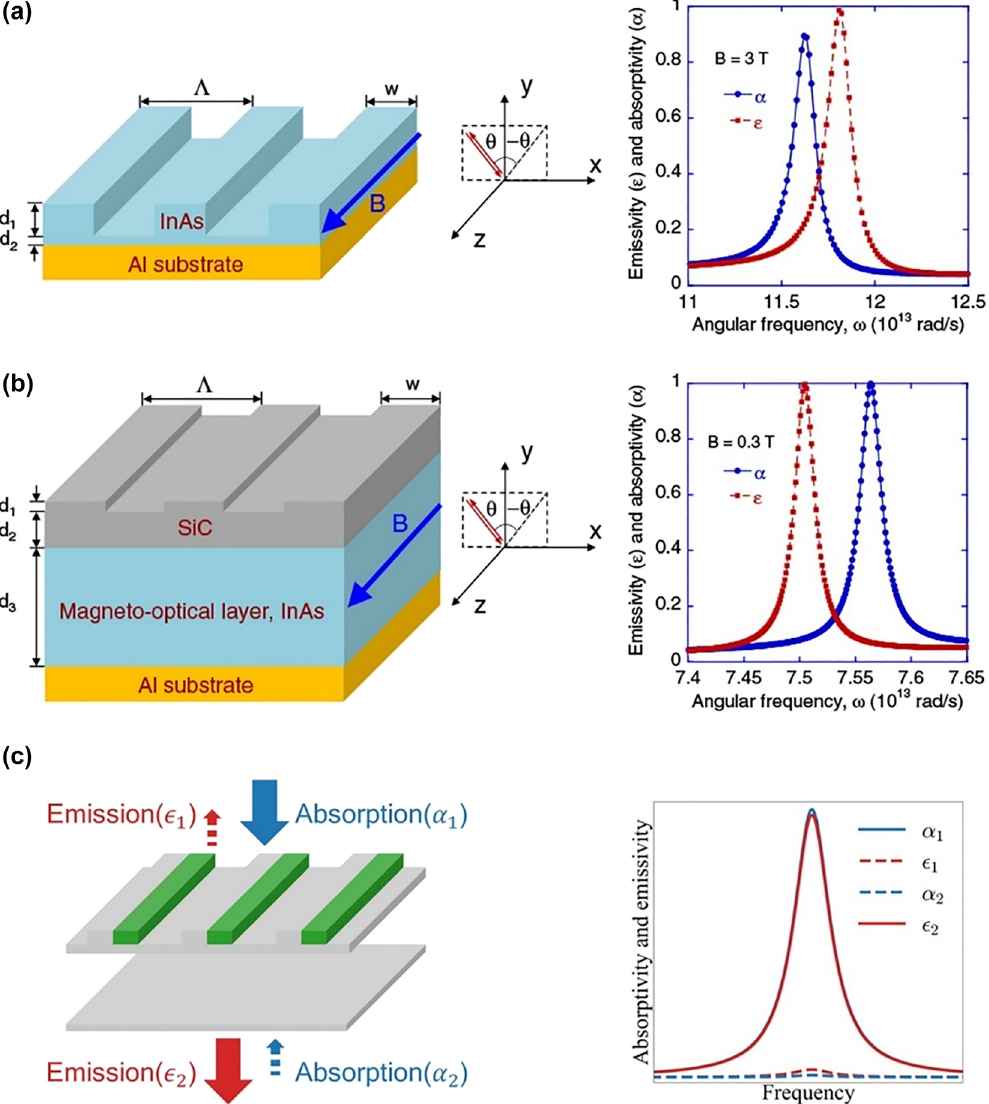
Figure 6: Violation of Kirchhoff ’ s law of thermal radiation in all-dielectric MO subwavelength gratings. (a) Structure, absorption, and emission spectra of InAs gratings on an Al substrate under 3 T applied magnetic fi eld. The emission and absorptionspectrapresentdifferentpeakpositionsundertheappliedmagnetic fi eld.(b)Structure,absorption,andemissionspectrumof SiC grating on InAs fi lm on an Al substrate under 0.3 T applied magnetic fi eld. The emission and absorption peaks separate under the applied magnetic fi eld. (c) All-dielectric MO grating for violation of the Kirchhoff ’ s law of thermal radiation in the transmission mode. Large transmission difference of absorption and emission is observed under an applied magnetic fi eld. The panels of this fi gure contain pictures adapted from References [63, 64,